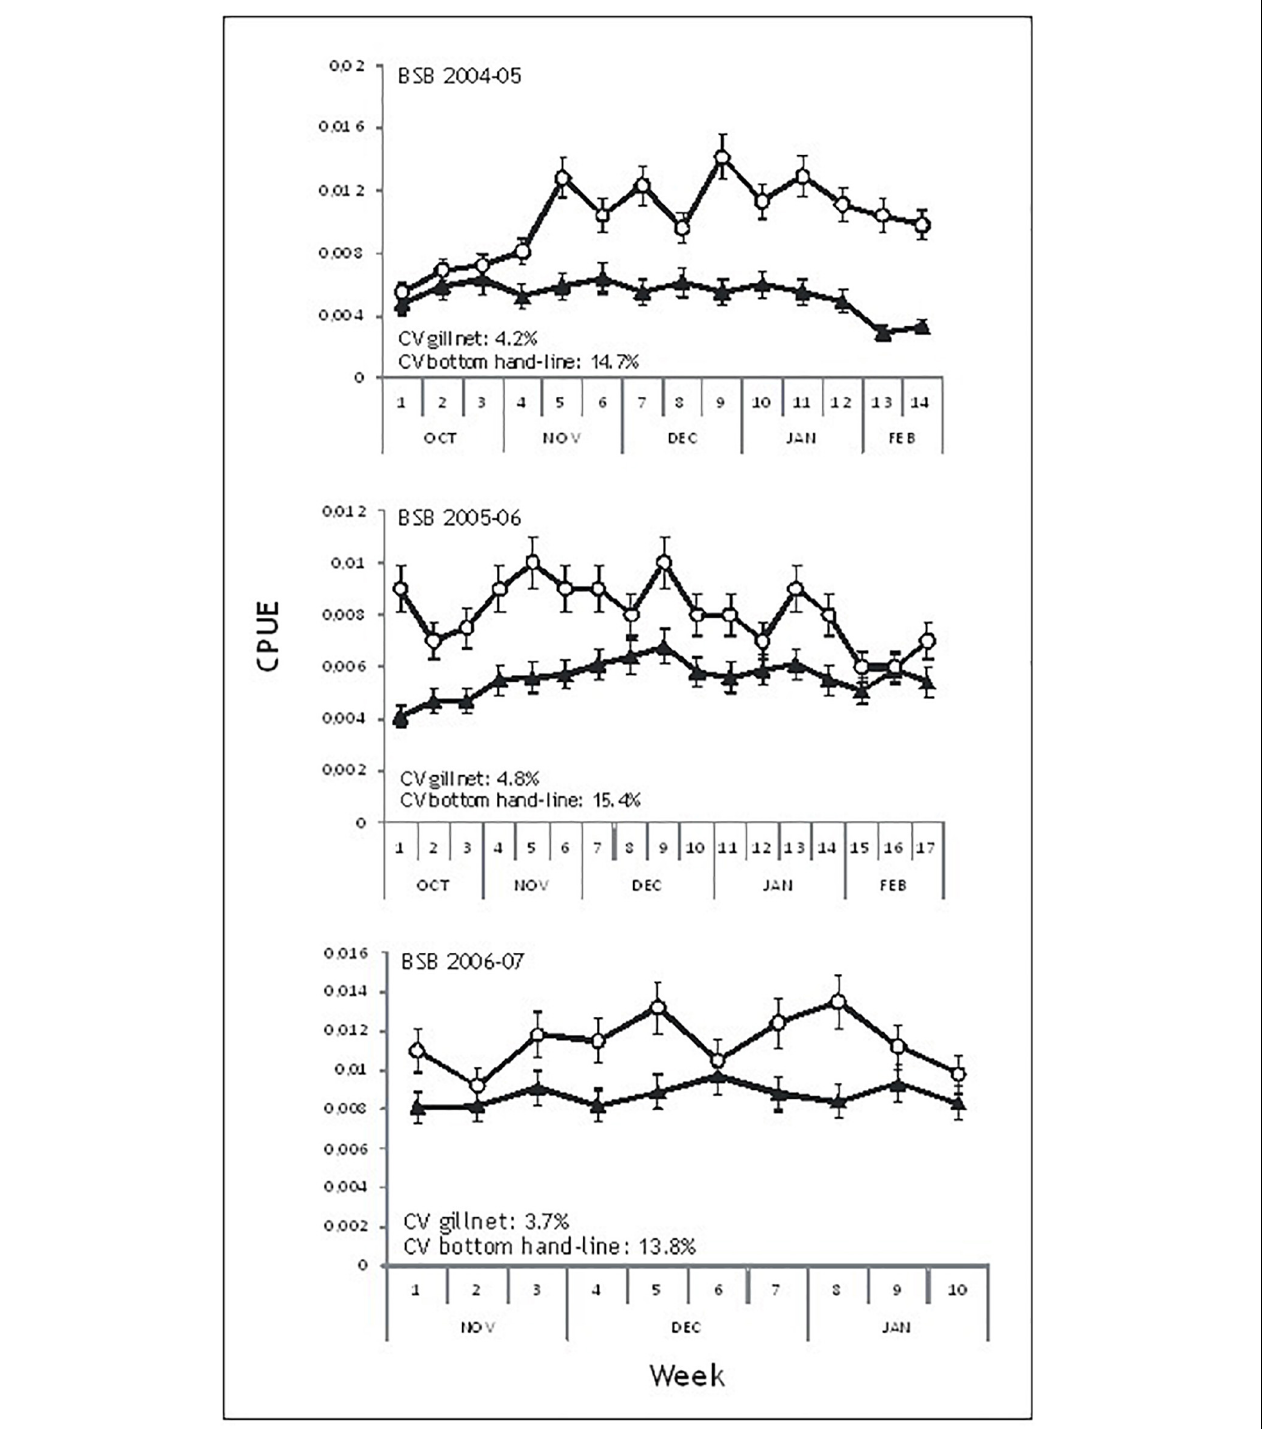
FIGURE 4 | Variability of CPUE and SE in gillnets (black triangle) and bottom longlines (white circle) in BSB. THE CPUE for bottom longlines is expressed as CPUE - 1 .